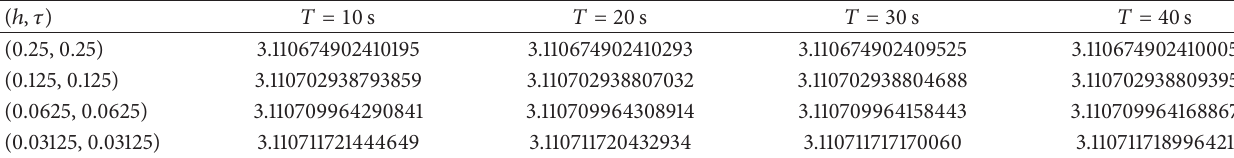
Table 4: The energy of different time in different time step and space step for 𝑝 = 5